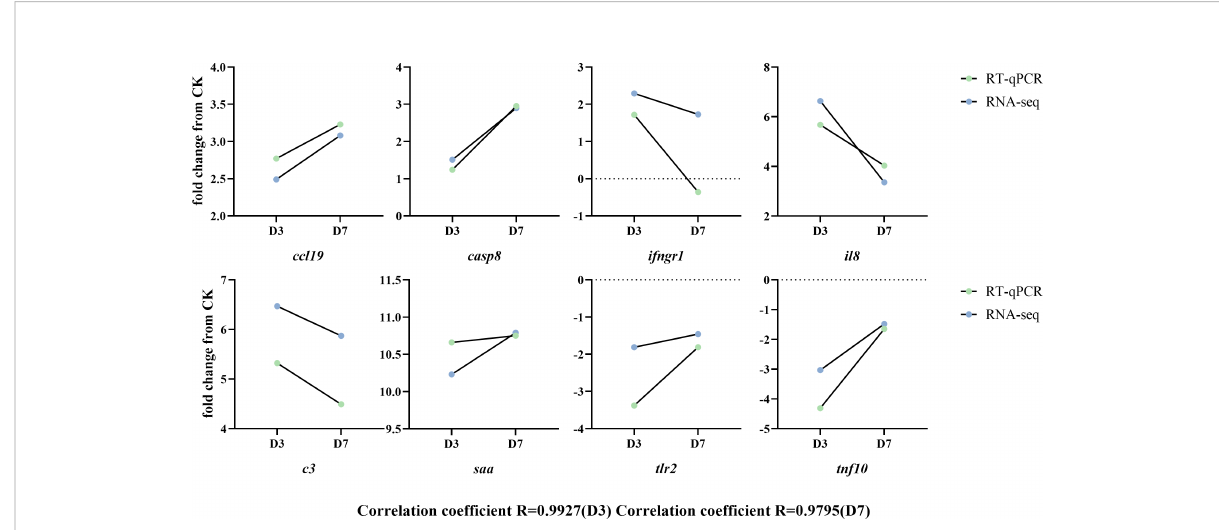
FIGURE 7 Validation of selected differentially expressed genes by RT-qPCR. Fold changes in rainbow trout at 3 and 7 days postinfection (D3 and D7) with F. psychrophilum are expressed as the ratios of gene expression at D3 and D7 to gene expression in the CK as normalized with the b -actin gene . ccl19 , C-C chemokine ligand 19; c3 , complement C3; casp8 , caspase 8; saa , serum amyloid A; ifngr1 , interferon gamma receptor 1 precursor; tlr2 , Toll-like receptor 2; il8 , interleukin 8/permeability factor 2; tnf10 , TNF superfamily member